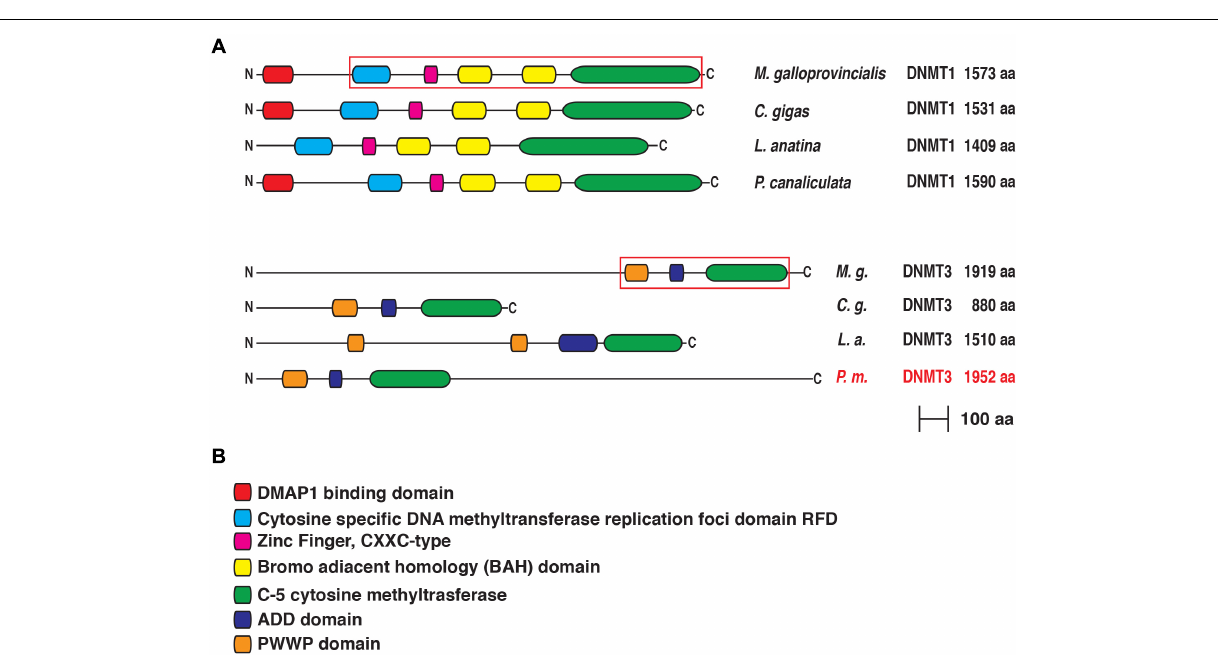
FIGURE 2 | (A) Conserved domain organization of DNMT1 and DNMT3 of Mytilus galloprovincialis in comparison with those of Crassostrea gigas , Lingula anatina and Pomacea canaliculata . For DNMT3 we used the sequence of Pomacea maculata (in red) instead of Pomacea canaliculata . The phylogenetically informative regions used for Bayesian inference are included in a red box. (B) List of the functional domains. For each protein the N-terminus is on the left and the C-terminus is on the